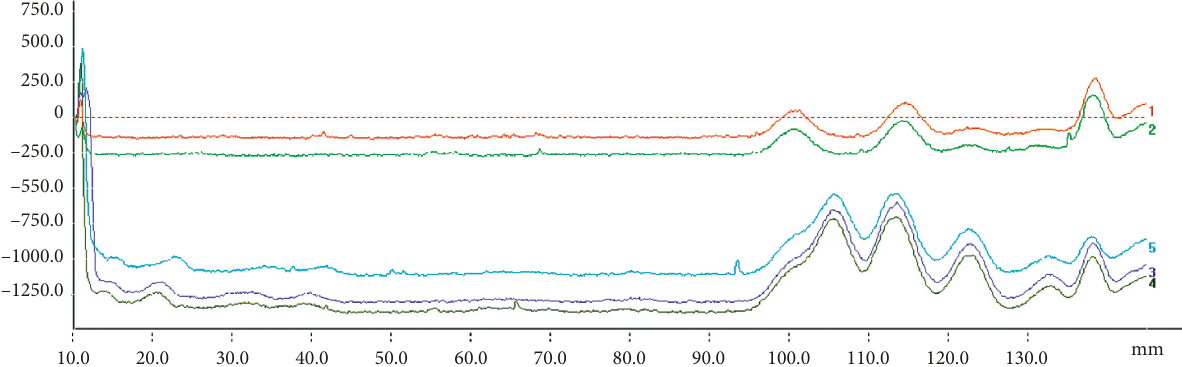
Figure 2: HPTLC 3D diagram of the test solution. Note . 1 and 2 are HPTLC scanning images of the mixed standard solution, and 3–5 are HPTLC scanning images of the sample solution. The chromatographic peaks from left to right were oxypeucedanin, imperatorin, osthole, columbianadin, and Table 2: Standard curve. Linear regression Correlation Component equation coefficient